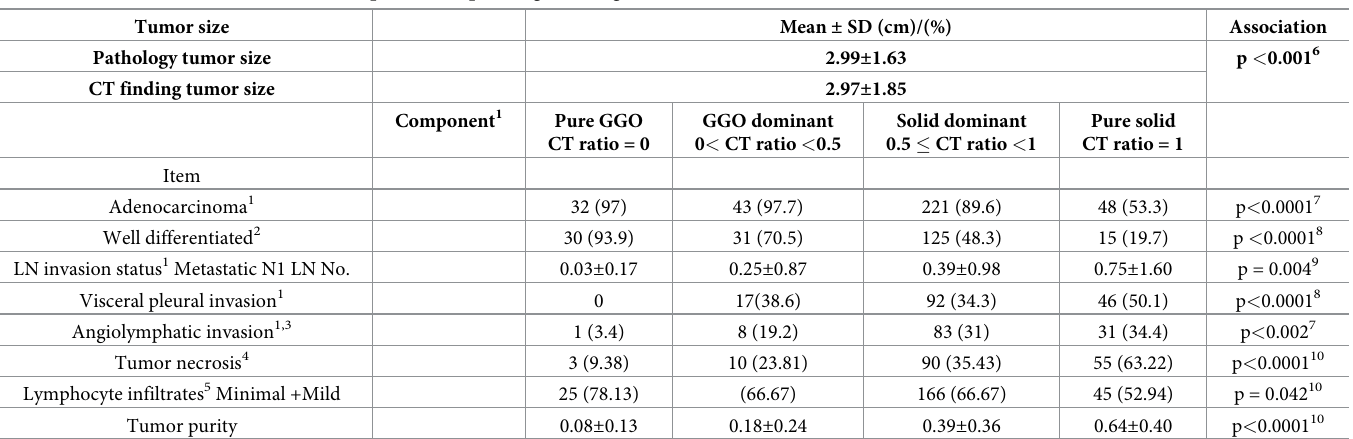
Table 2. Correlation between CT tumor component and pathologic findings.